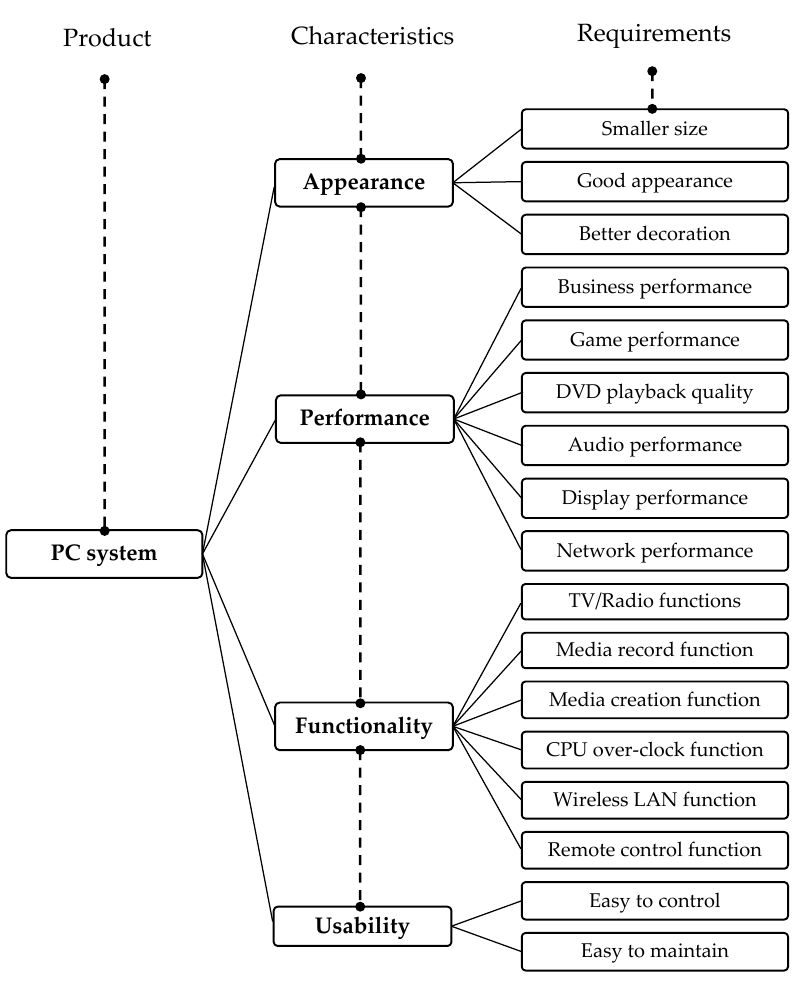
Figure 1. Tree diagram of the specific requirements for a new product [10].